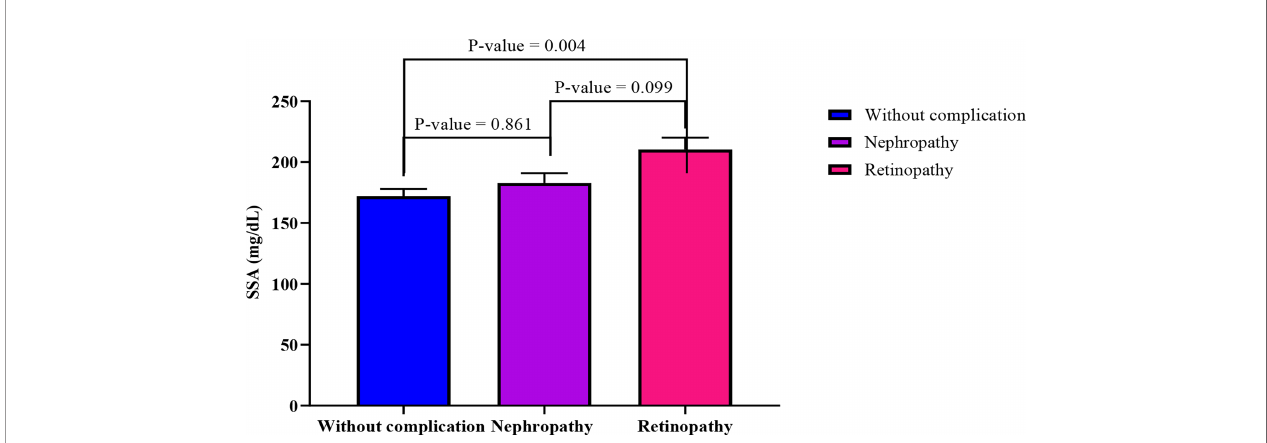
FIGURE 2 | Comparison of estimated marginal means across the three groups using ANCOVA analysis adjusting for TG and BAI. The following values were obtained from the test of between subject model: F= 5.50, R 2 = 0.079, p-value= 0.005, sum of squares =